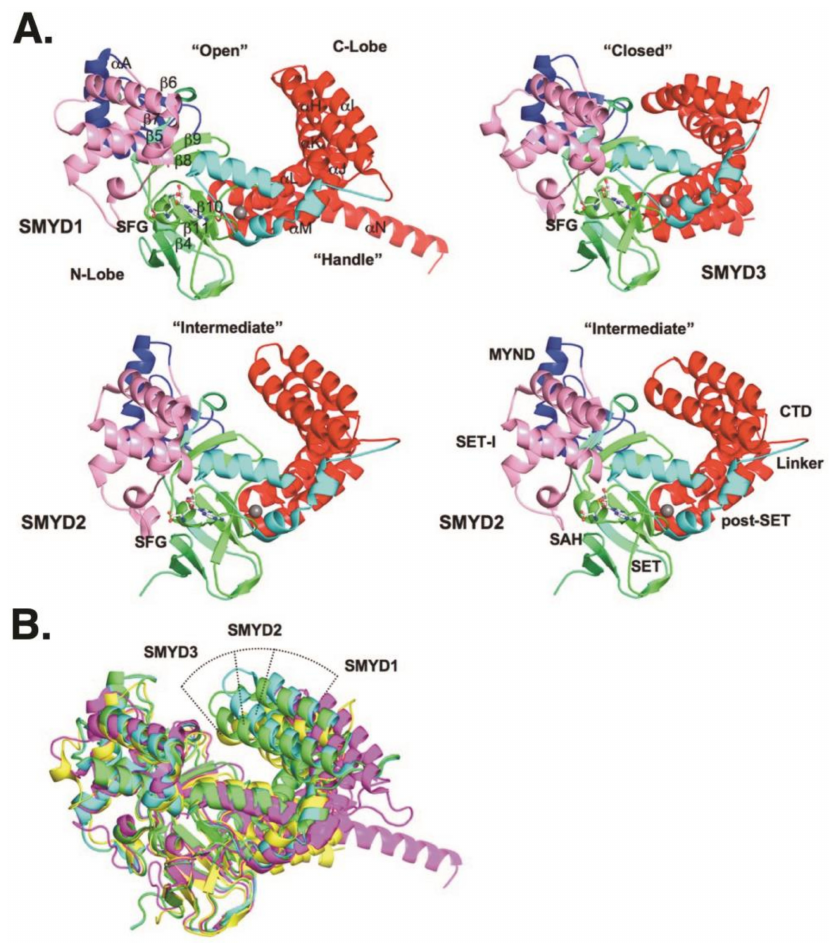
Figure 2. Domain structures of SMYD1, SMYD2, and SMYD3 proteins. ( A ) Ribbon diagrams of SMYD1 (PDB code: 3N71), SMYD2 (PDB code: 3QWV and 3QWW), and SMYD3 (PDB code: